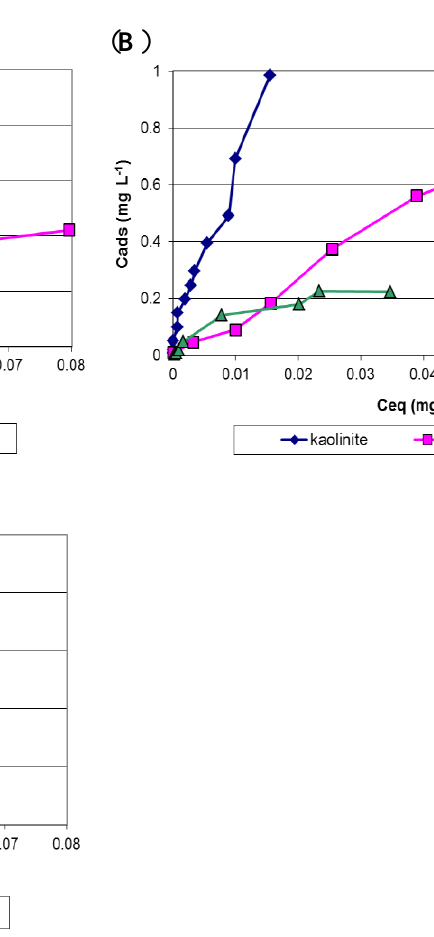
Figure 2. Adsorption isotherms of different PAHs at water/sand, water/silt and water/kaolin interfaces at 25 °C. ( A ) phenanthrene; ( B ) pyrene; ( C ) indeno[ 1,2,3,cd